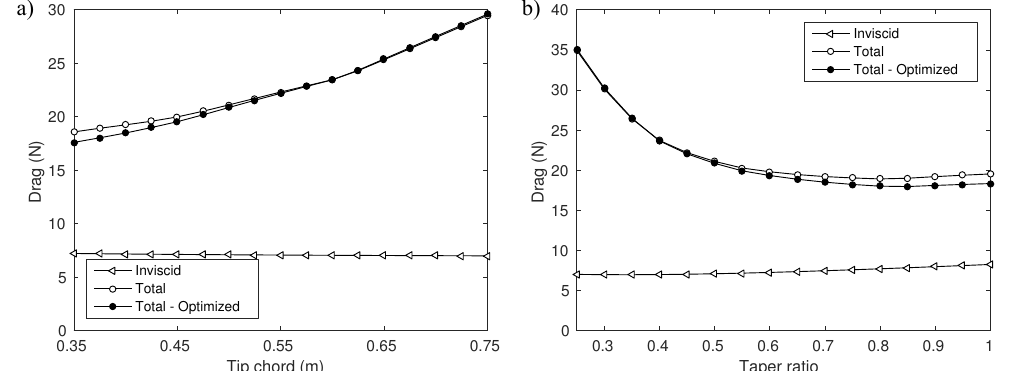
Figure 20. Sensitivity study: ( a ) tip chord length; ( b ) taper